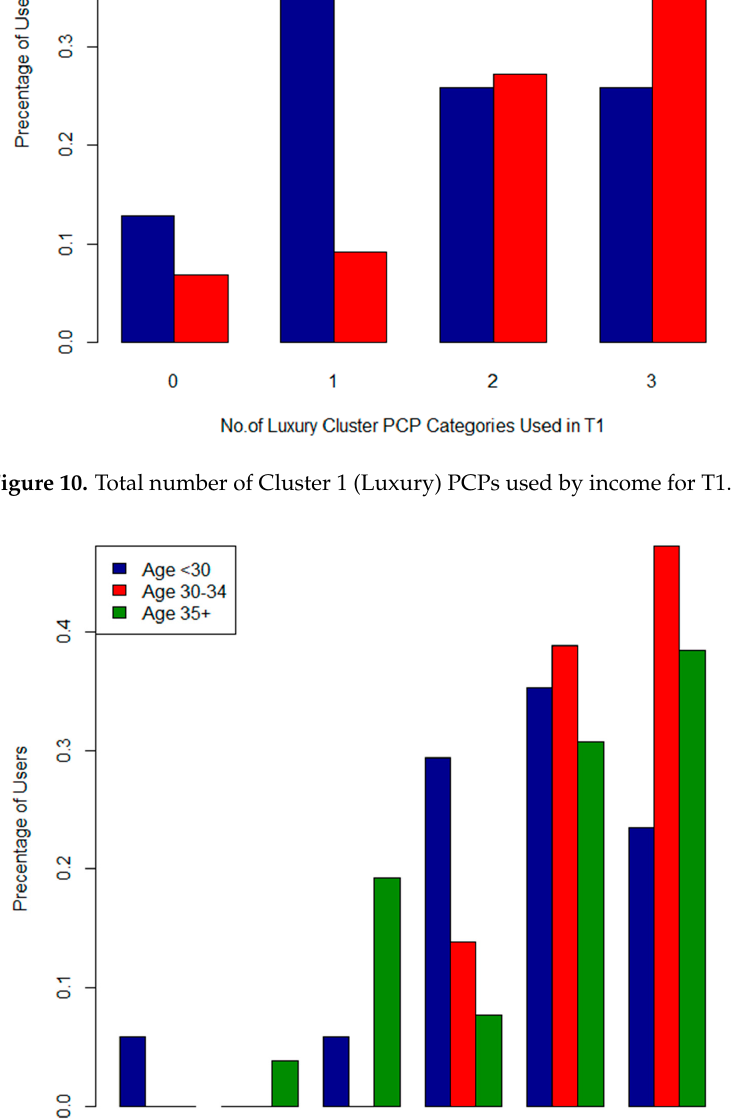
Figure 11. Total number of Cluster 2 (Daily) PCPs used by age for T1.